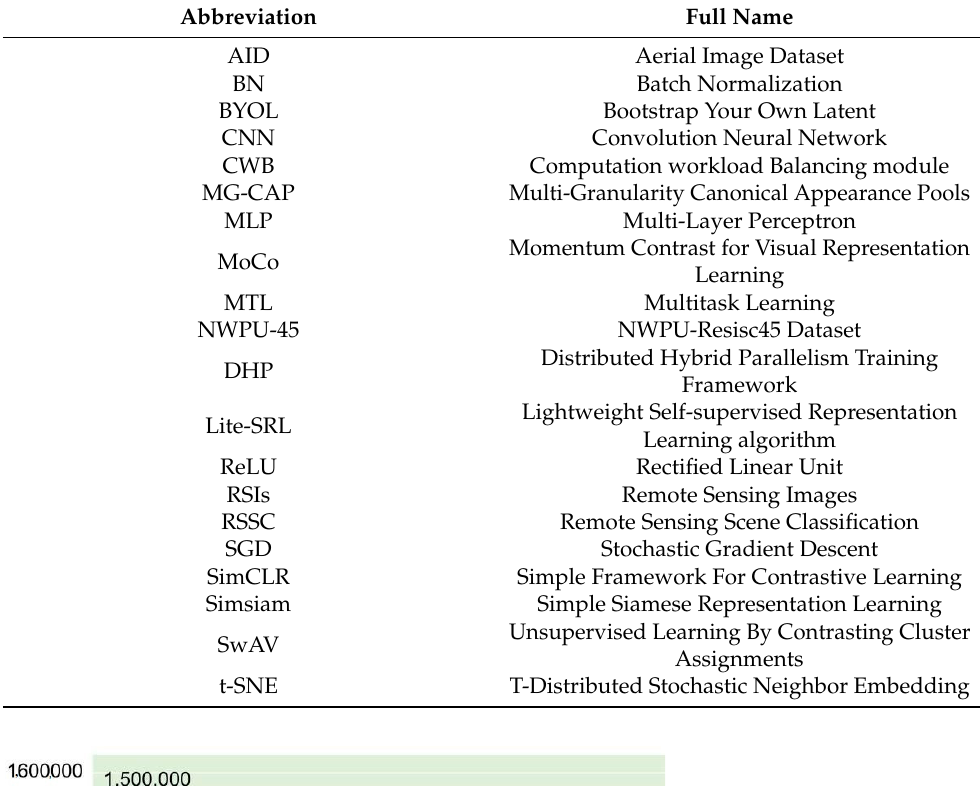
Table A1. The abbreviations and corresponding full names, organized in alphabetical order.